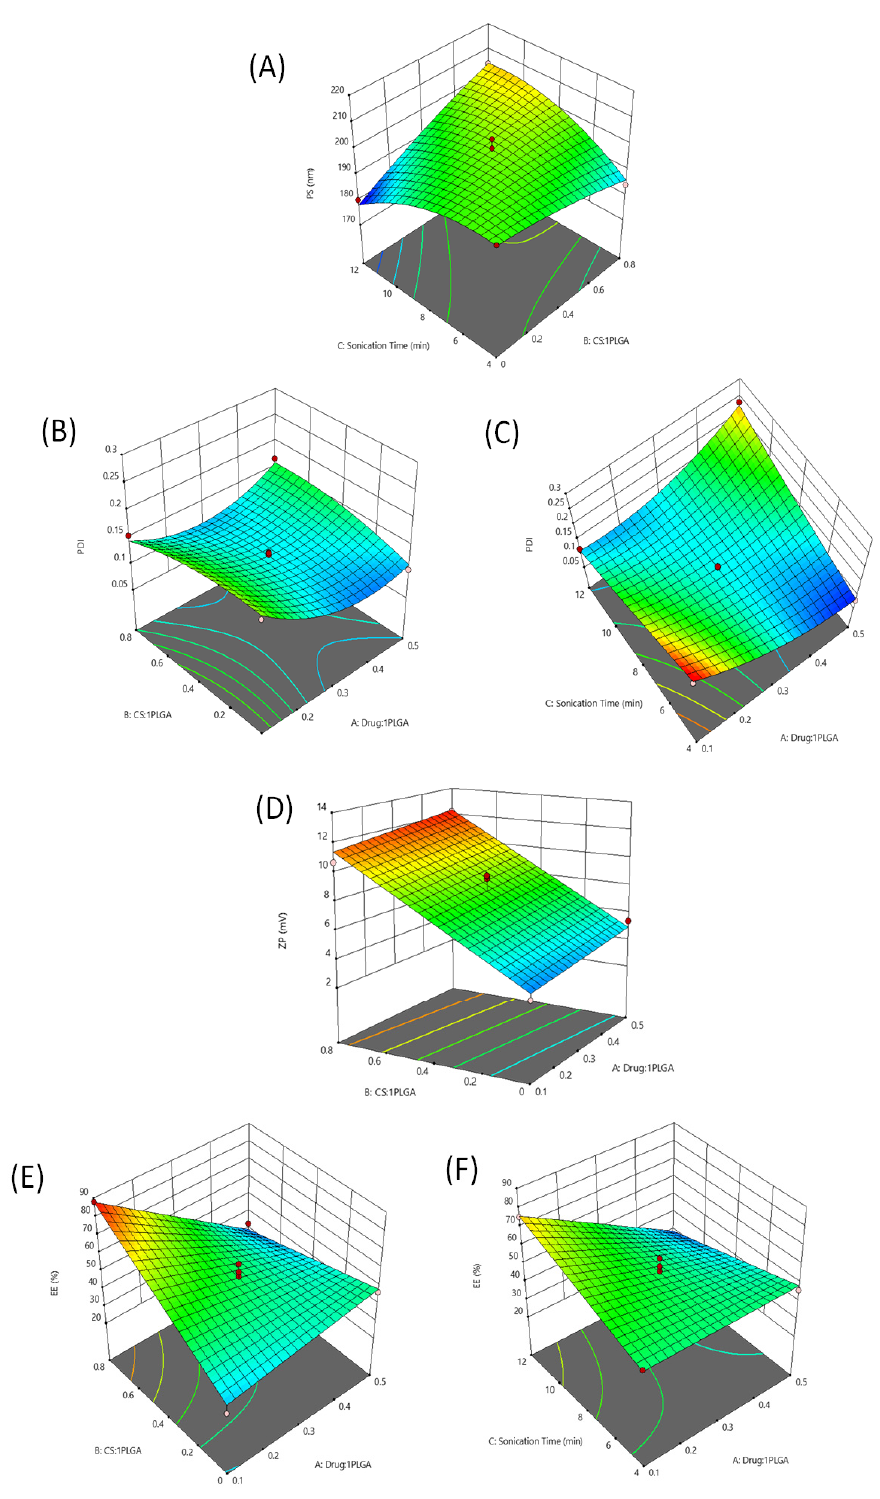
Figure 1. Three-dimensional surface plots for the main effects and interactions of the HARF: PLGA ratio, the CS: PLGA ratio, and the sonication time on PS ( A ), PDI ( B , C ), ZP( D ), and EE % ( E , F ).